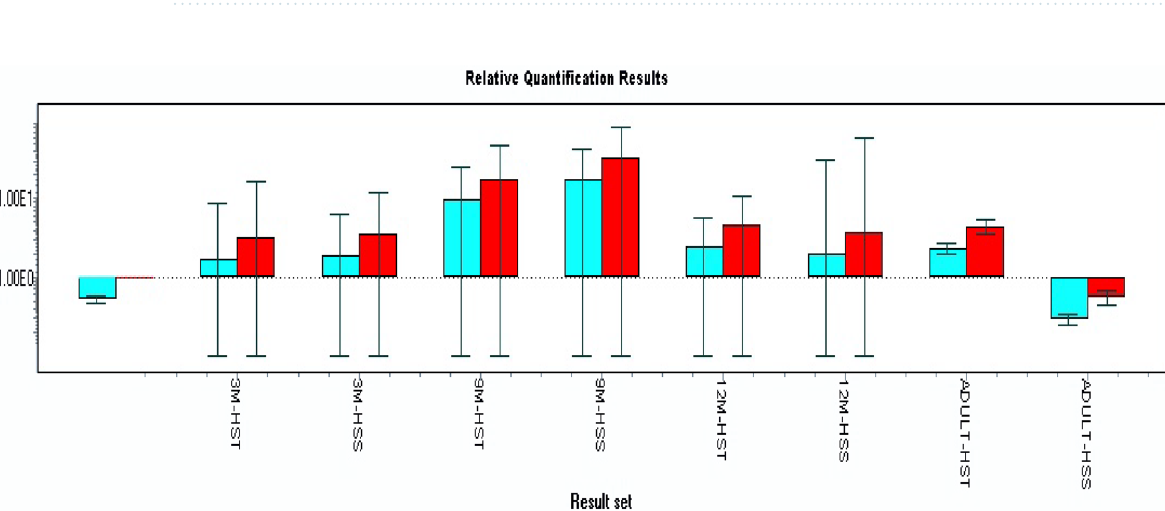
Table 5. Relative mRNA expression (Fold change) of HSP70 gene at different age groups of Jamunapari goat with respect to HST and HSS phenotype. No. Number or sample size; 3, 9, 12 month and adult, Age of Jamunapari goats.